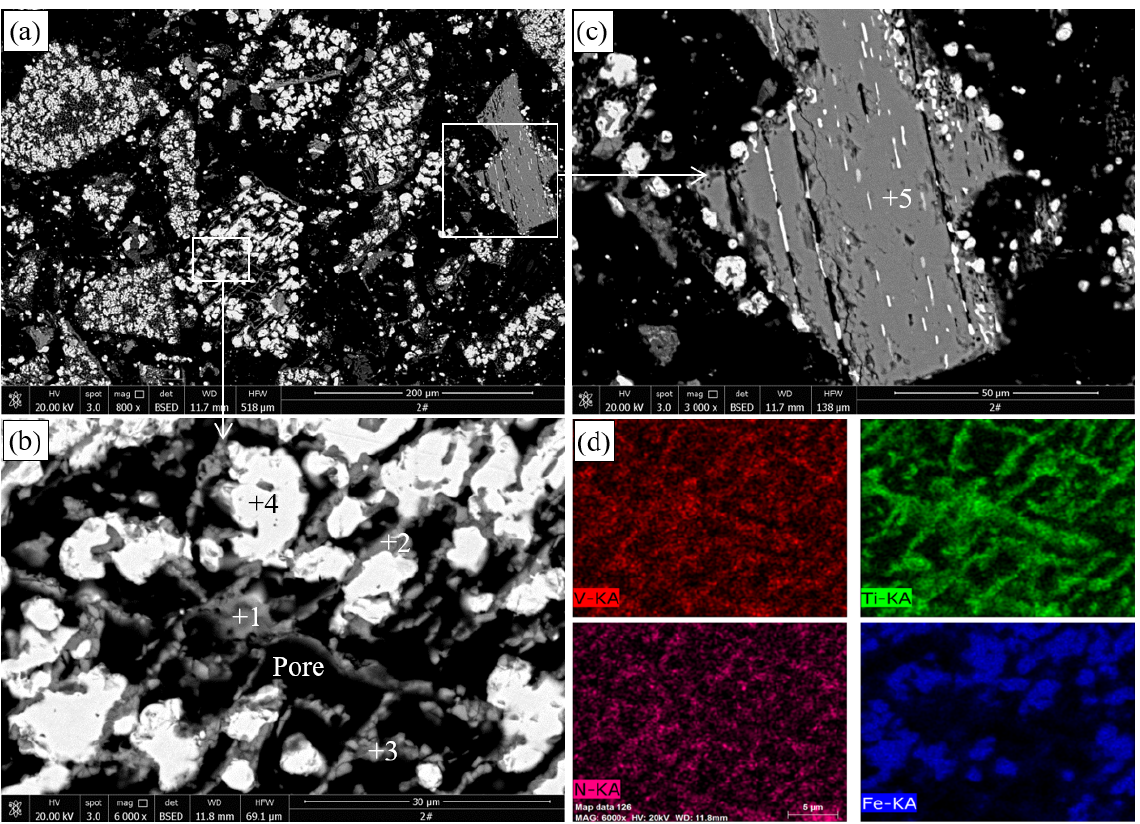
Figure 4. Microstructure and EDS results of the pellets roasted at 1000 ◦ C for 90 min: ( a ) typical SEM image; ( b ) the reduced titanomagnetite; ( c ) the reduced ilmenite; ( d ) V, Ti, N, and Fe elemental maps of the area shown in ( b ).